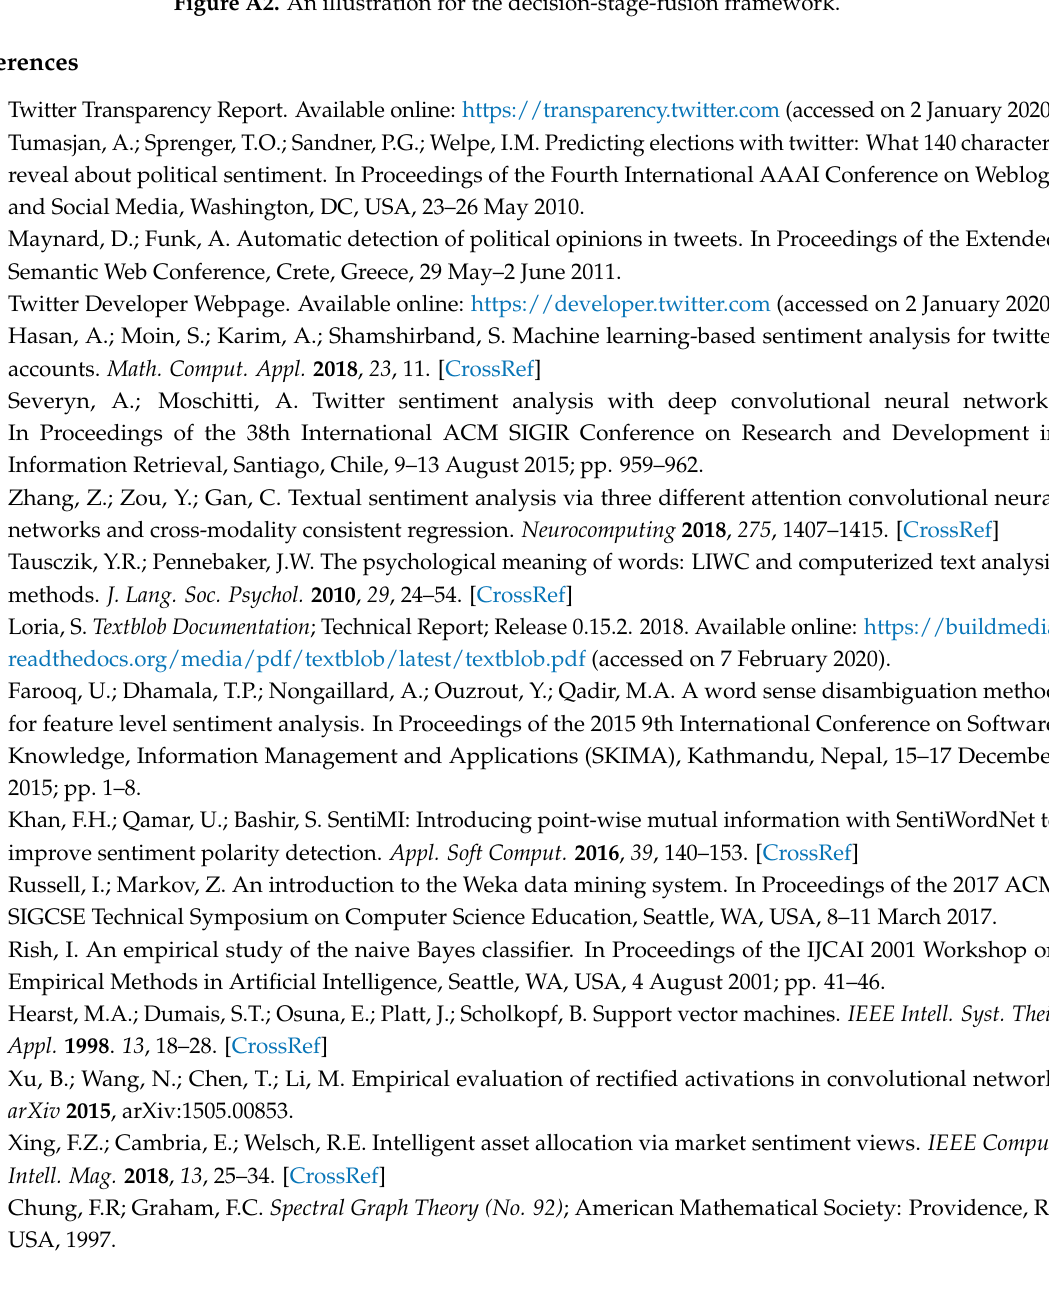
Figure A2. An illustration for the decision-stage-fusion